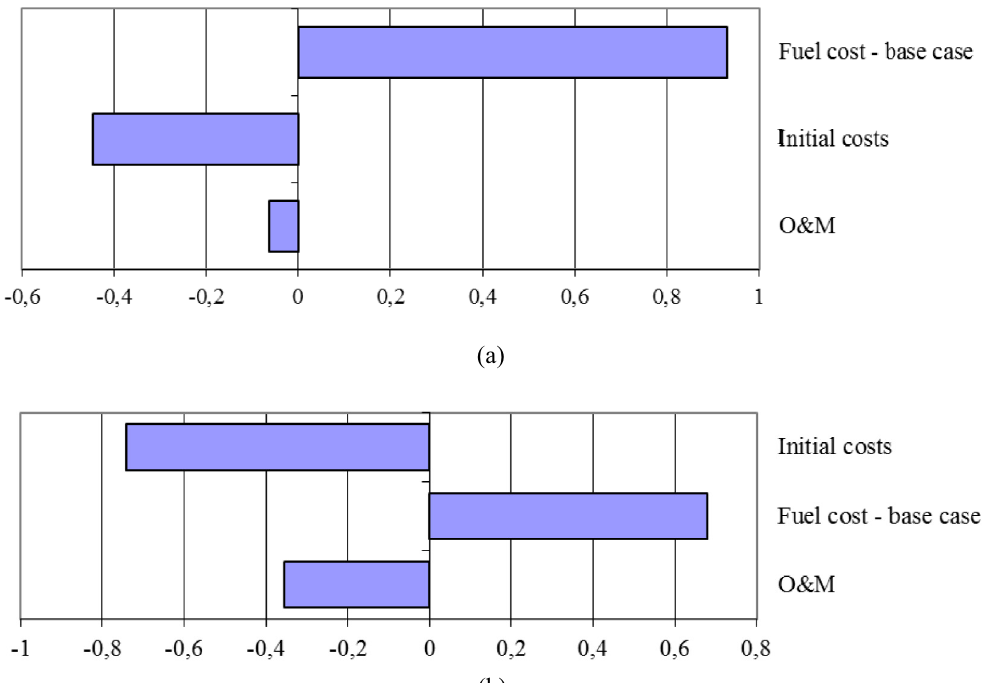
Fig. 5. Impact on NPV for (a) PV system (electricity part) and (b) solar thermal system (heating part).